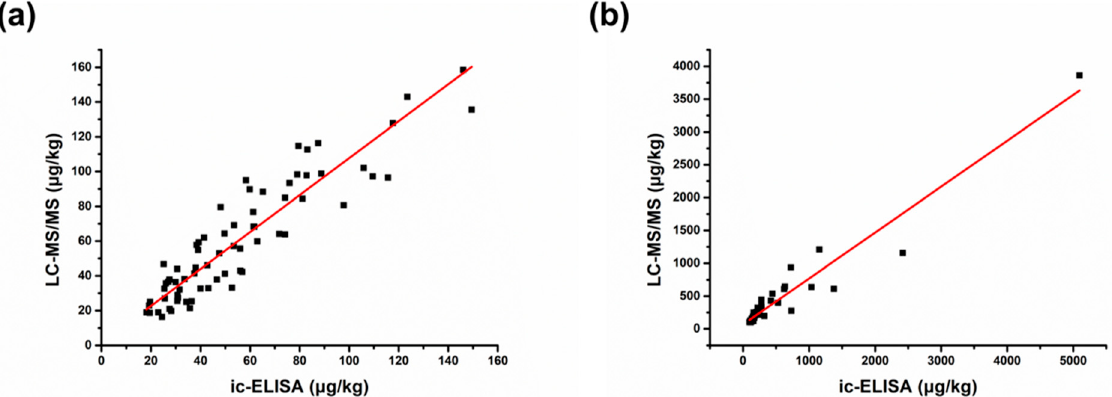
Figure 5. Correlation curves for ZEN in coix seed between the developed ic-ELISA and the LC- MS/MS fitted by the method of weighted least square. ( a ) MRL 60 μ g/kg; ( b ) MRL 500 μ g/kg.